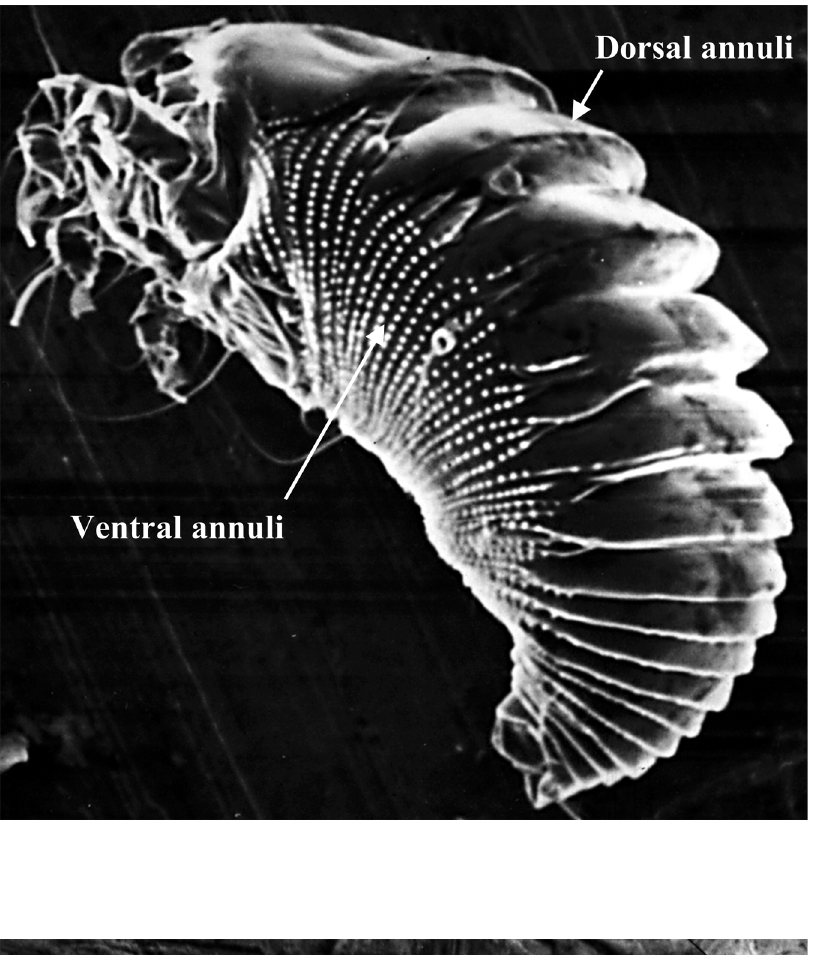
Fig. 10. A “fusiform” eriophy- id mite Coptophylla lamimani (Keifer) (courtesy of De Lillo).